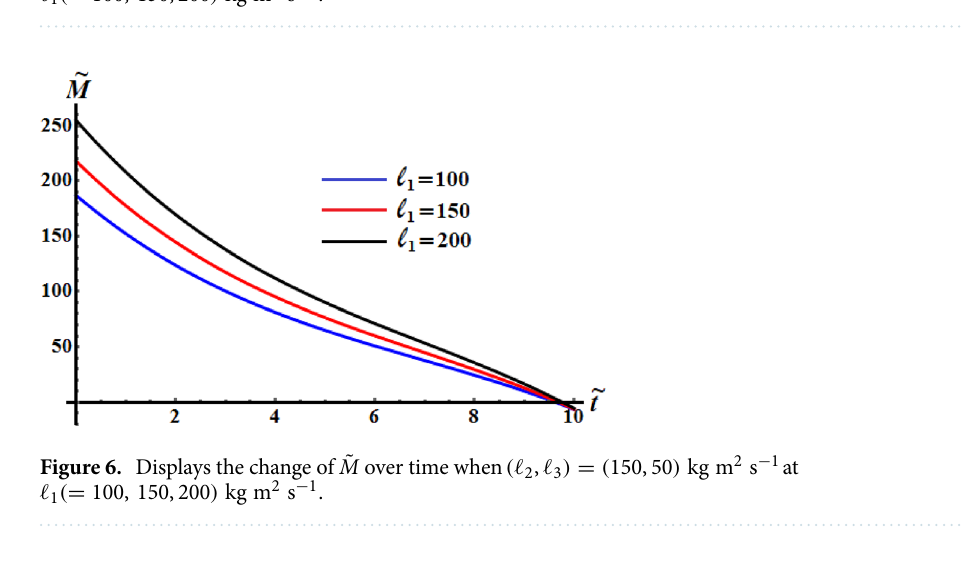
Figure 5. Shows the change of the kinetic energy ˜ H over time when (ℓ 2 , ℓ 3 ) = ( 150, 50 ) kg m 2 s − 1 at ℓ 1 ( = 100, 150, 200 ) kg m 2 s − 1 .